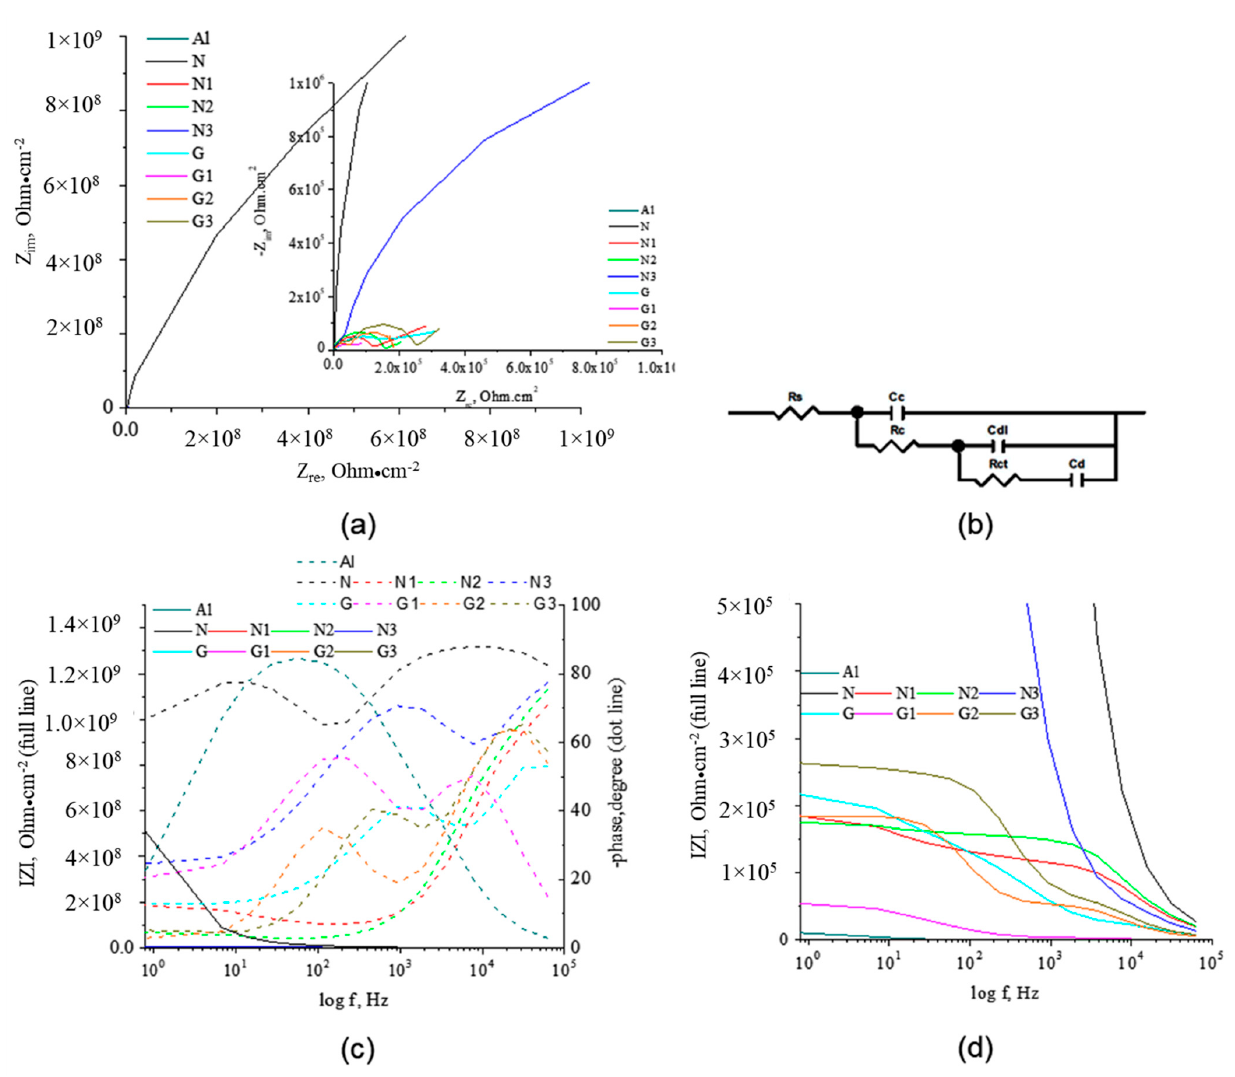
Figure 3. Diagrams ( a ) Nyquist and detailed Nyquist; ( b ) electric equivalent circuit; ( c ) Bode impedance modulus IZI and phase angle, and ( d ) detailed IZI versus log f, for all electrodes after 60 min immersion in 3% NaCl solution at potential OCP, V.